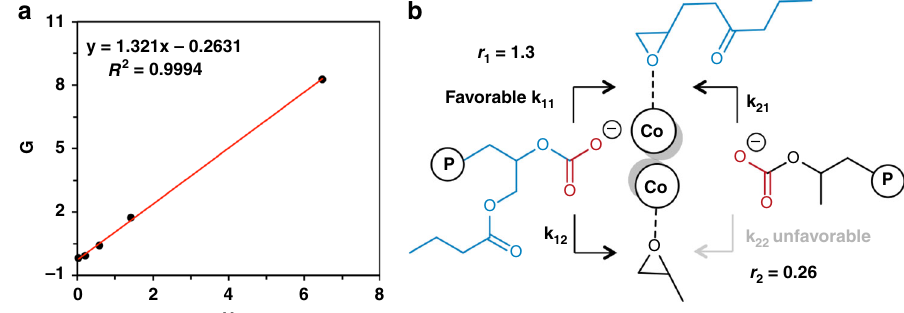
Fig. 2 Probabilistic sequence distribution of monomers in the terpolymer. a Fineman – Ross plot of PPGBC at low conversions. X = [ f [GB] / f [PO] , Y = [ F [GB] / F H = Y 2 / X , G = Y ( X − 1)/ X . b Schematic of propagation reactions. Source data are provided as a Source Data fi le and data for Fig. 2a is provided [PO] ],